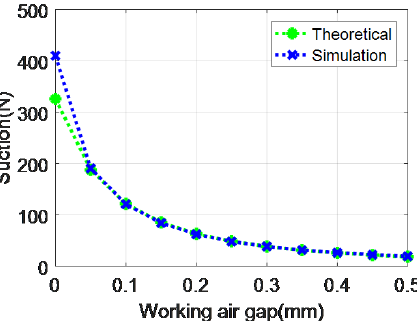
Figure 10. Relationship between working air gap and magnetic flux density. Figure 11. Relationship between working air gap and suction for theoretical derivation and simulation calculation.